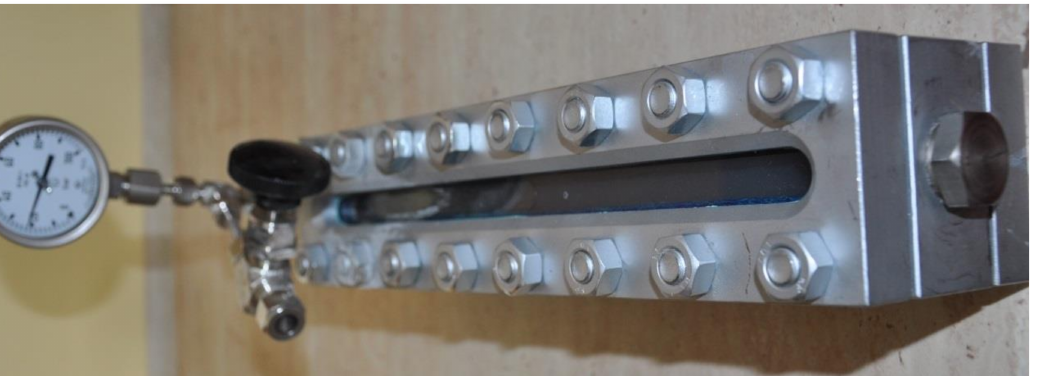
Figure 2. The chamber pressure